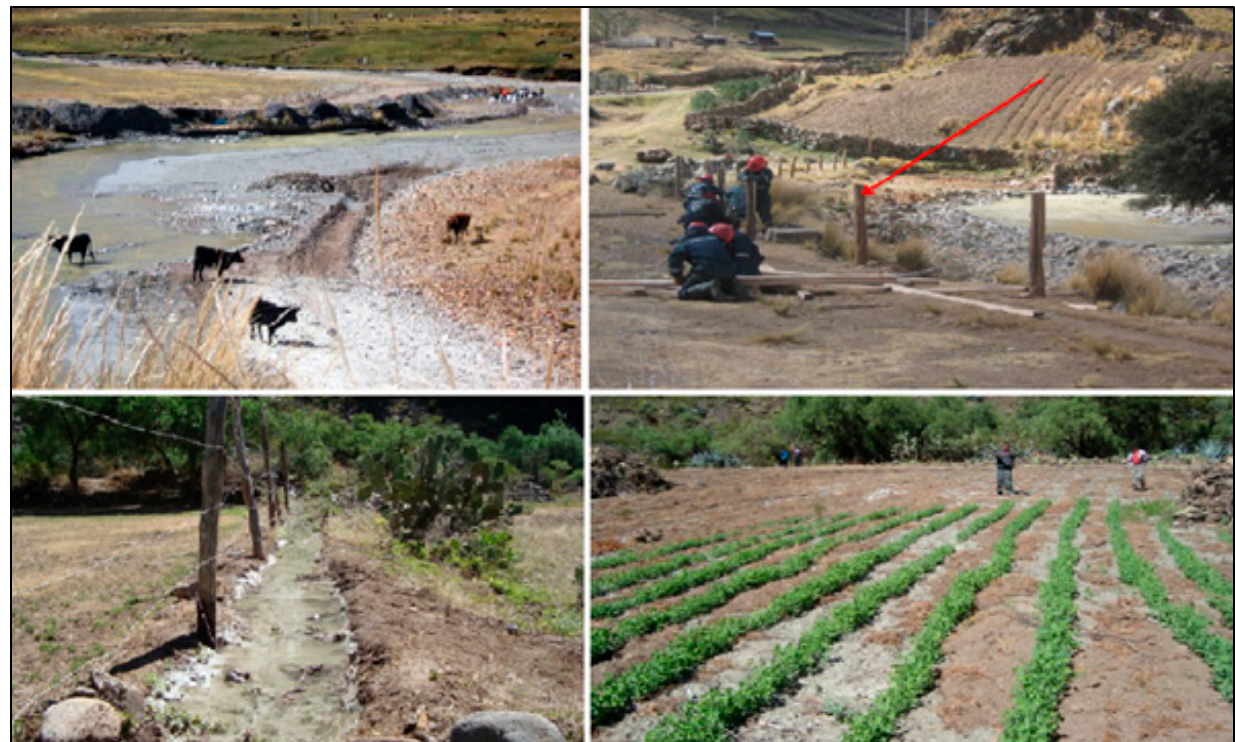
Figure 12. Tailings removal by community and miners, impacts on aquatic biota [45,46].